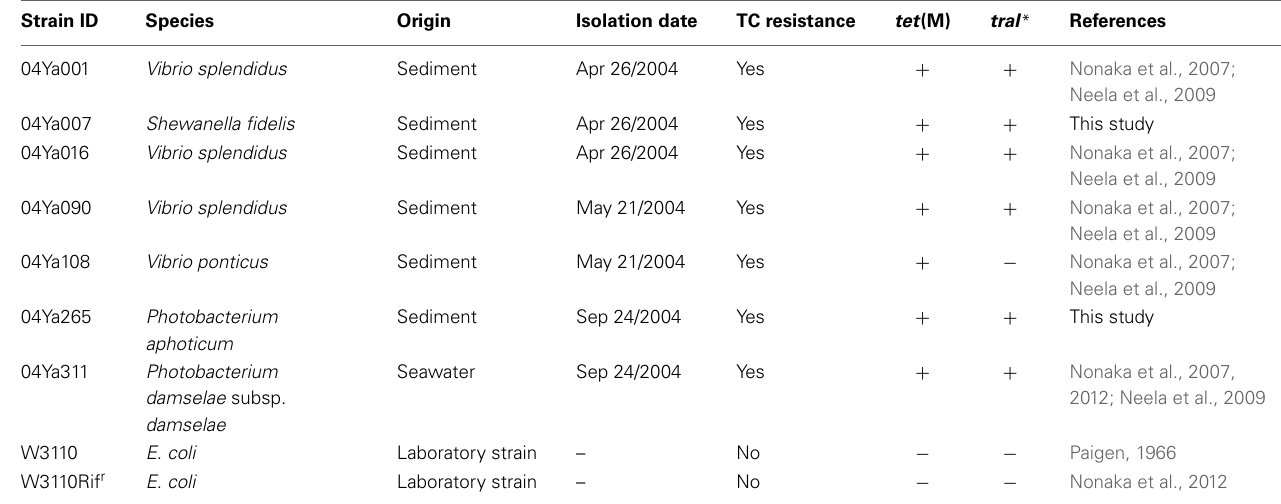
Table 3 | Strains harboring traI gene belonging to the MOBH 12 clade in the MOB H family on the basis of a PCR screening. Strain